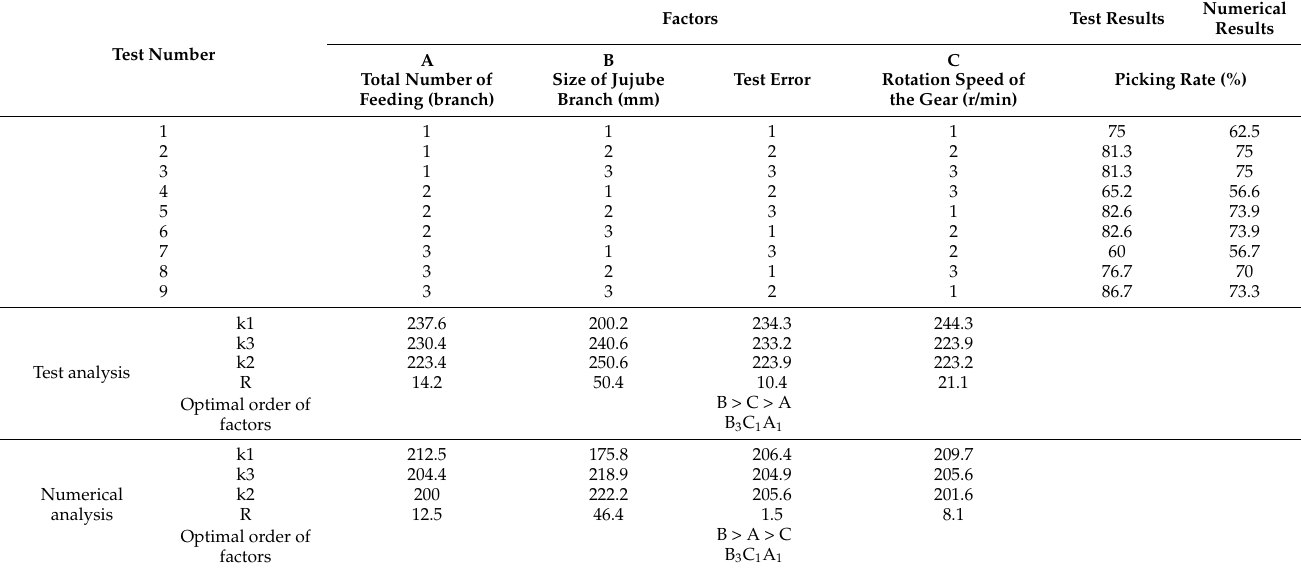
Table 4. Experimental design and comparative analysis with simulation